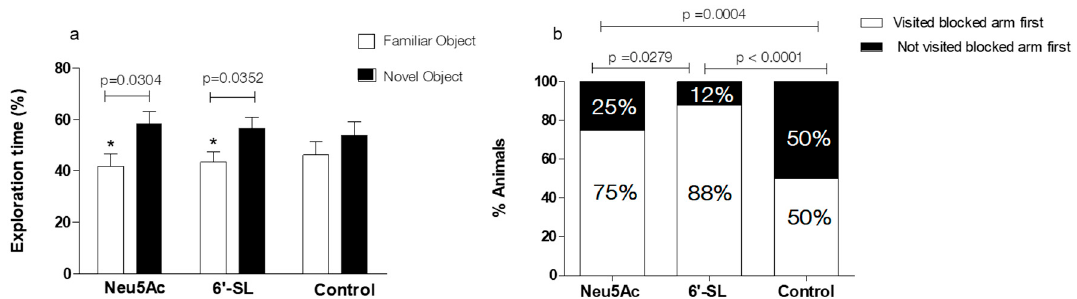
Figure 4. ( a ) Percentage of time spent by the animals exploring a familiar object against a novel object in NORT at one year of age. One-way ANOVA and Student’s t -test were applied for statistical analysis; *, p < 0.05 denotes significant differences. ( b ) Percentage of animals that chose the novel arm first in the Y maze during the retention test versus those that did not. Fisher’s test was applied for statistical analysis; p < 0.05 denotes significant differences ( n = 8 rats/group). Neu5Ac, N-acetylneuraminic acid; 6 ′ -SL, 6 ′ -sialyllactose.